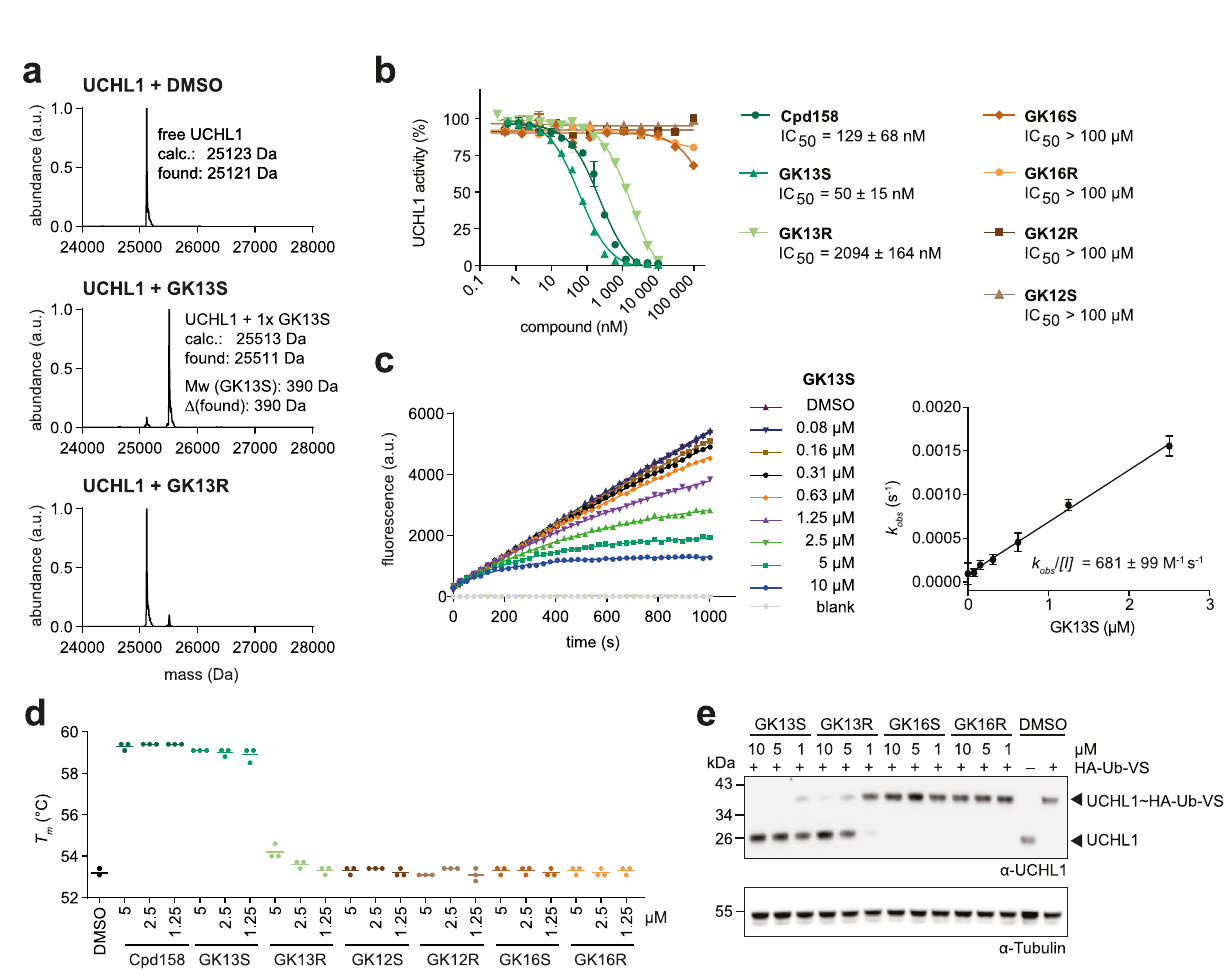
Fig.3|GK13SpotentlyinhibitsrecombinantandcellularUCHL1.a Intactprotein mass spectrometryrevealed covalent binding ofGK13Sand GK13Rto